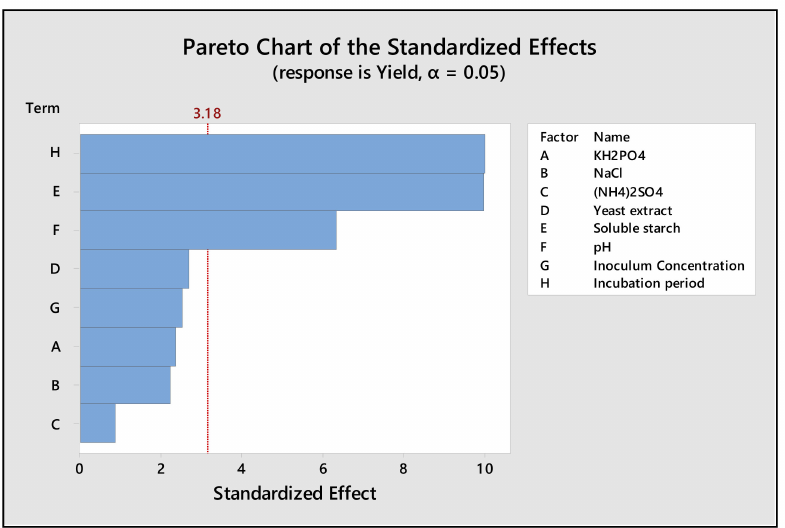
Figure 3. Pareto chart representing the effects of medium variables on amylase production by Bacillus sp. H7 ( p <